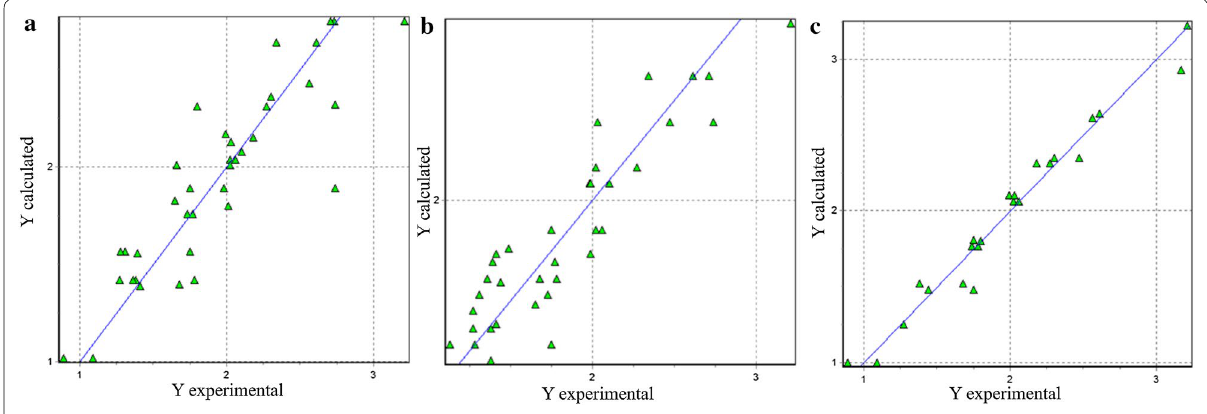
Fig. 2 Predicted versus experimental larvicidal activity from structural–activity relationship models. a Model 1, b model 3, c model 5